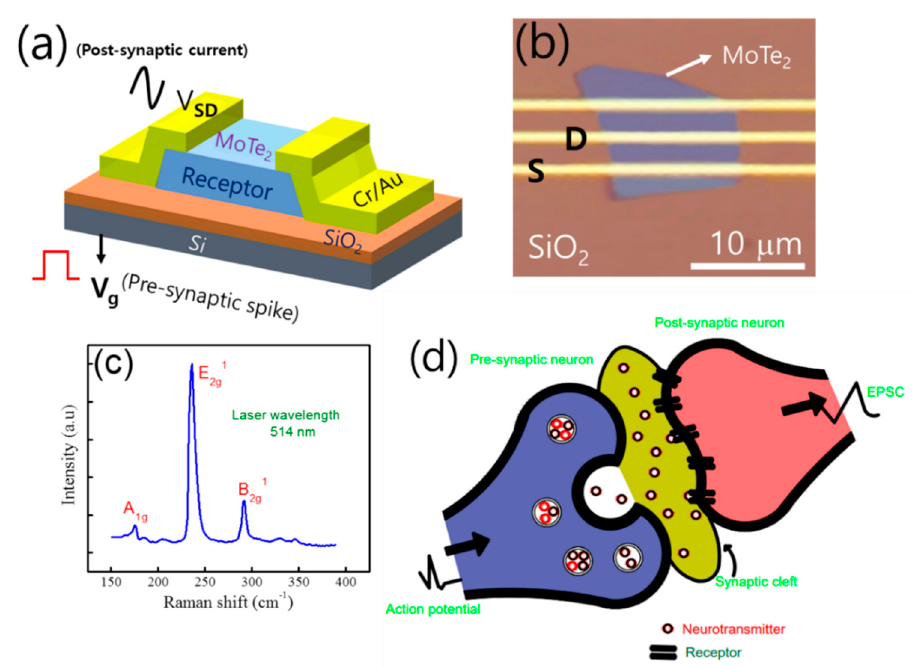
Figure 1. ( a ) The schematic illustration of MoTe 2 three terminal field effect transistors (FET) where charge trapping and de-trapping dynamics at atomically thin channel 2D material/SiO 2 interface. ( b ) The final optical microscope image of MoTe 2 FET with Cr/Au electrodes. ( c ) Raman spectroscopy of few layer MoTe 2 . ( d ) Presentation of a biological synapse where action potentials control the release and absorption of neurotransmitters.